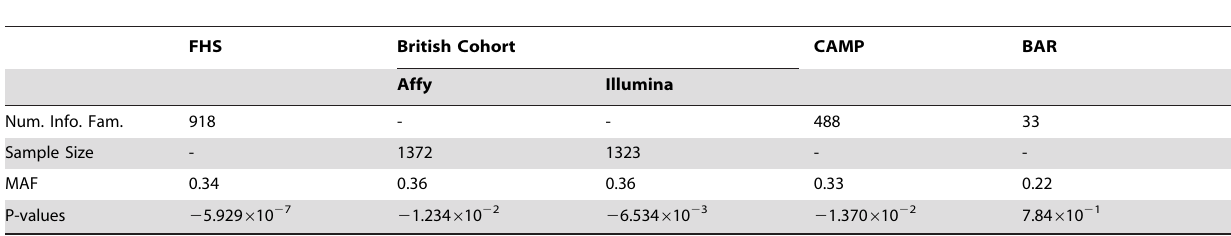
Table 7. Descriptive statistics and results of rs805294 in different studies.